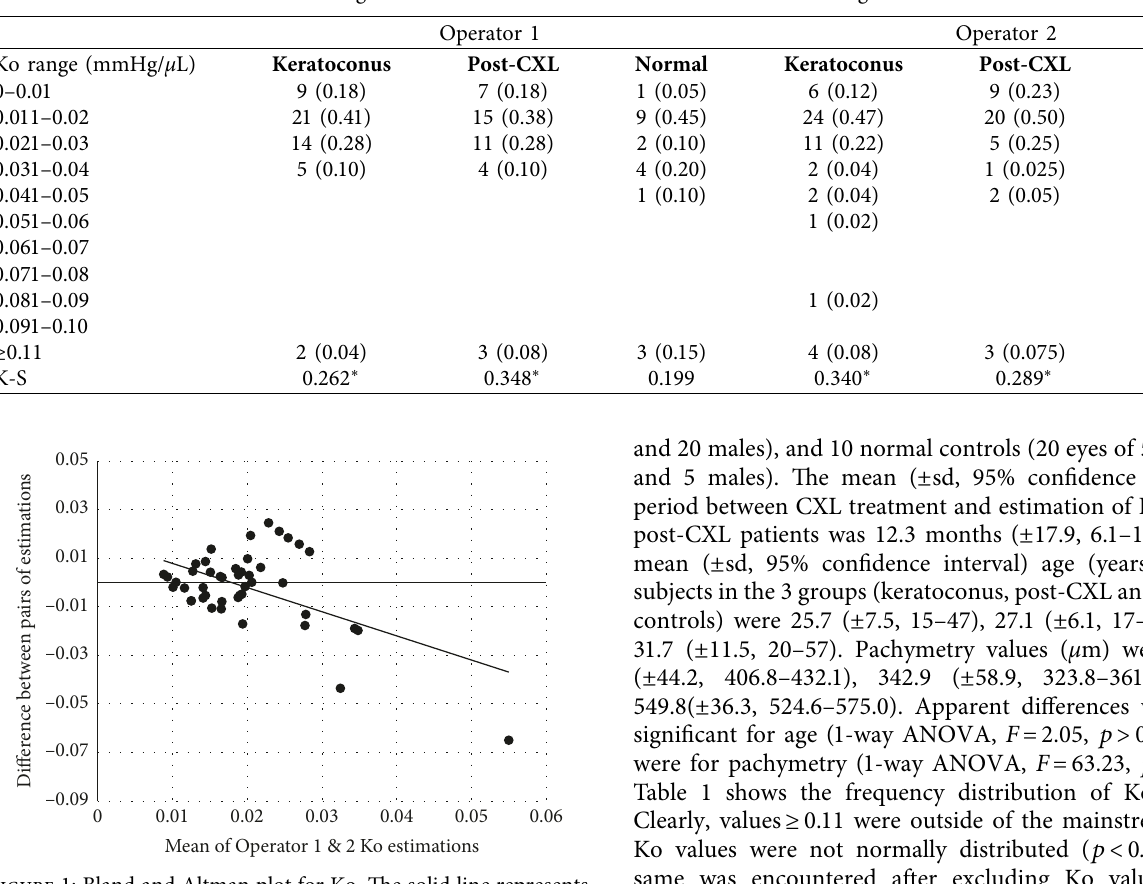
Table 1: Distribution of Ko estimations according to results taken by the two operators from keratoconus, post-CXL, and normal controls. The number of Ko values (proportion of total in parenthesis) per Ko range. K-S � Result of Kolmogorov–Smirnov test for normality of data in each column. ∗ Indicates where the significance of the K-S statistic was < 0.05 after excluding Ko values ≥ 0.11.